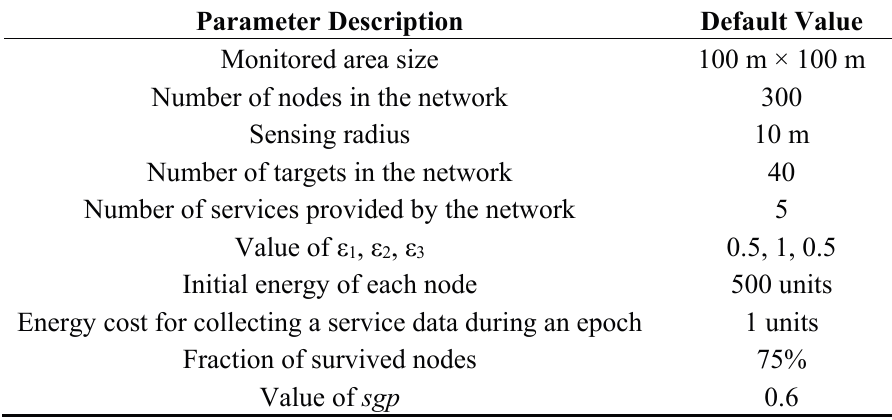
Table 2. Default values for the simulation